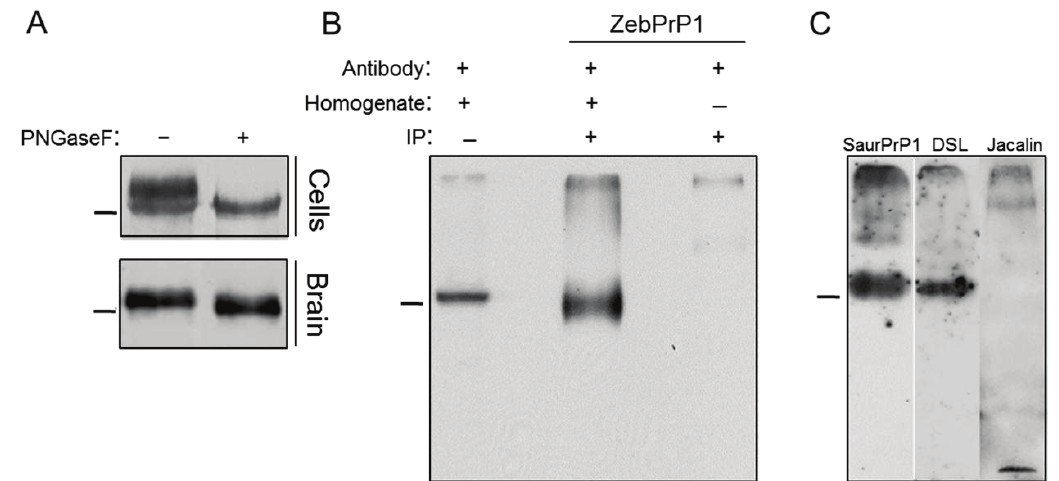
Figure 4. SaurPrP-1 is glycosylated in vitro and in vivo . ( A ) SaurPrP-1 transfected 22L-ScN2a cells (upper panel) or sea bream brain homogenate (lower panel) were treated (+) or not treated (−) with PNGaseF and then analyzed by Western blotting using SaurPrP1 antiserum (1:1000 and 1:20,000, respectively); ( B ) Isolation of SaurPrP-1 from sea bream brain by immunoprecipitation using ZebPrP1 antiserum (middle lane). Brain homogenate without immunoprecipitation treatment (left lane) and immunoprecipitation omitting the brain homogenate (right lane) were used as positive and negative controls, respectively; ( C ) Lectin staining of immunoprecipitated SaurPrP-1. Blotting with SaurPrP1 polyclonal antibody was used as positive control (left lane); the same immunoprecipitation fraction was probed with DSL (middle lane) and jacalin (right lane). Western blotting was performed using SaurPrP1 antiserum (1:20,000). Relative molecular mass markers, 47.5